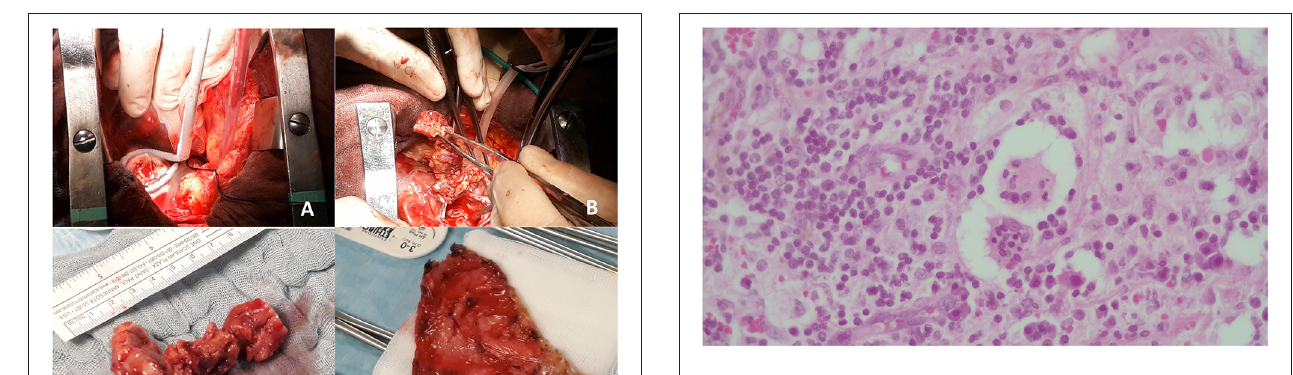
FIGURE 5 | The identification of emperipolesis, defined as the presence of an intact cell within the cytoplasm of another cell. This finding is reported to be typical of RDD and provides a differential diagnosis with PS100 + Erdheim-Chester